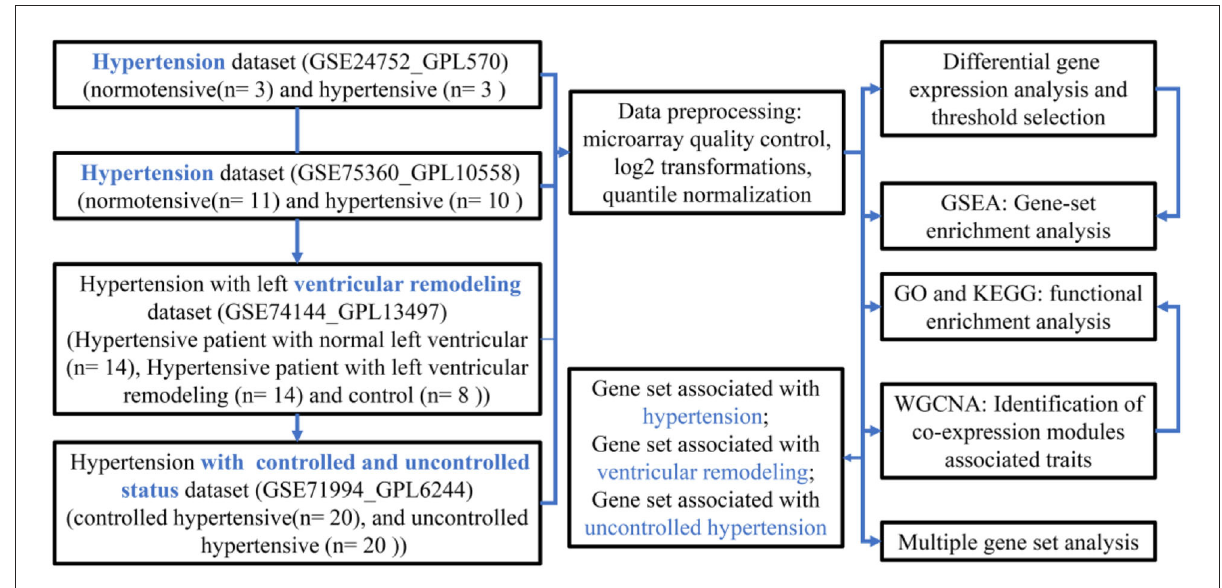
FIGURE1 A flowchart diagram of hypertension-related transcriptional dataset selection, pre-processing, and analysis for our study.